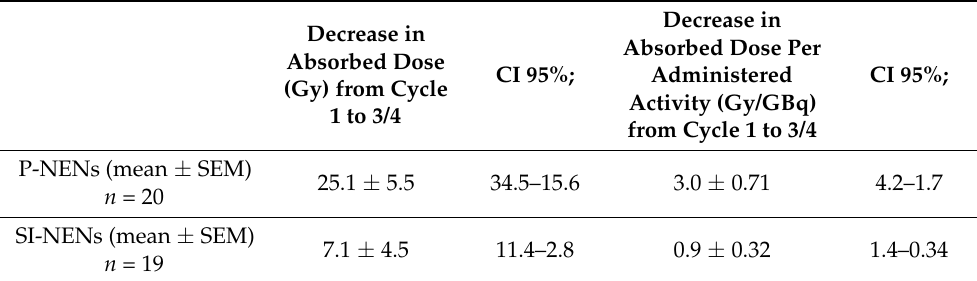
Table 4. Decrease in the absorbed tumor dose (Gy) and in the ratio between absorbed tumor dose and administered activity of 177 Lu-DOTATATE (Gy/GBq) from cycle 1 to cycle 3/4 (full seven-day dosimetry), in P-NEN and SI-NEN.